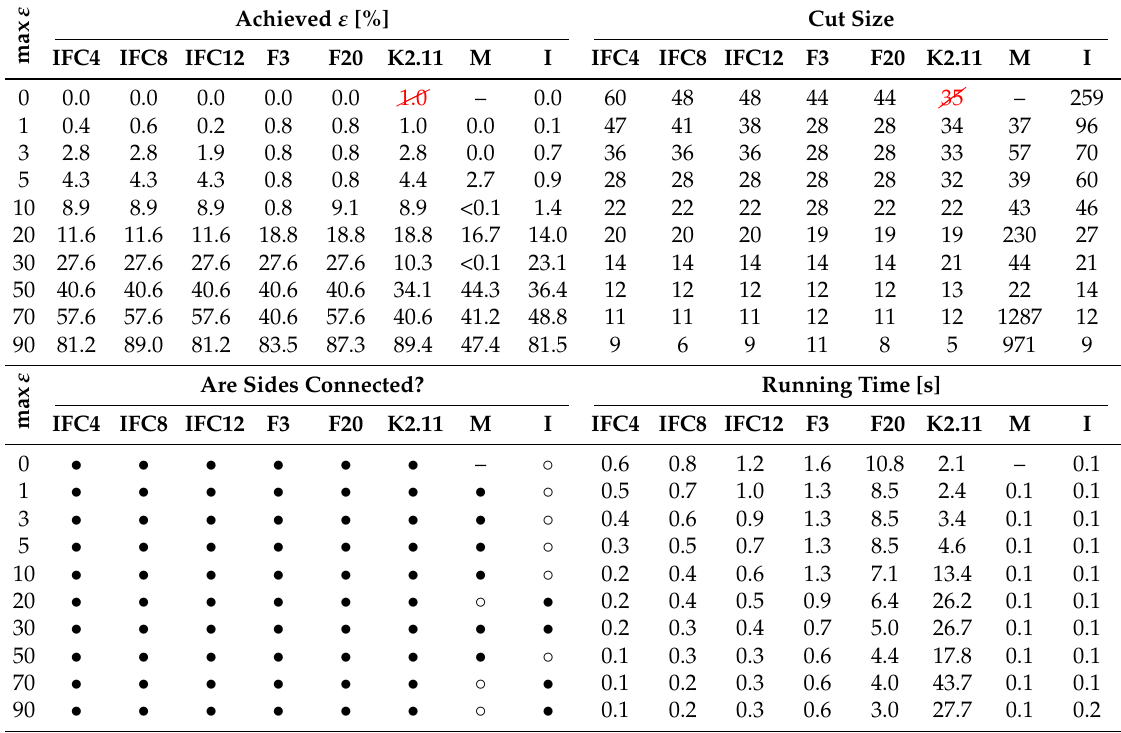
Table 4. Pareto cuts of